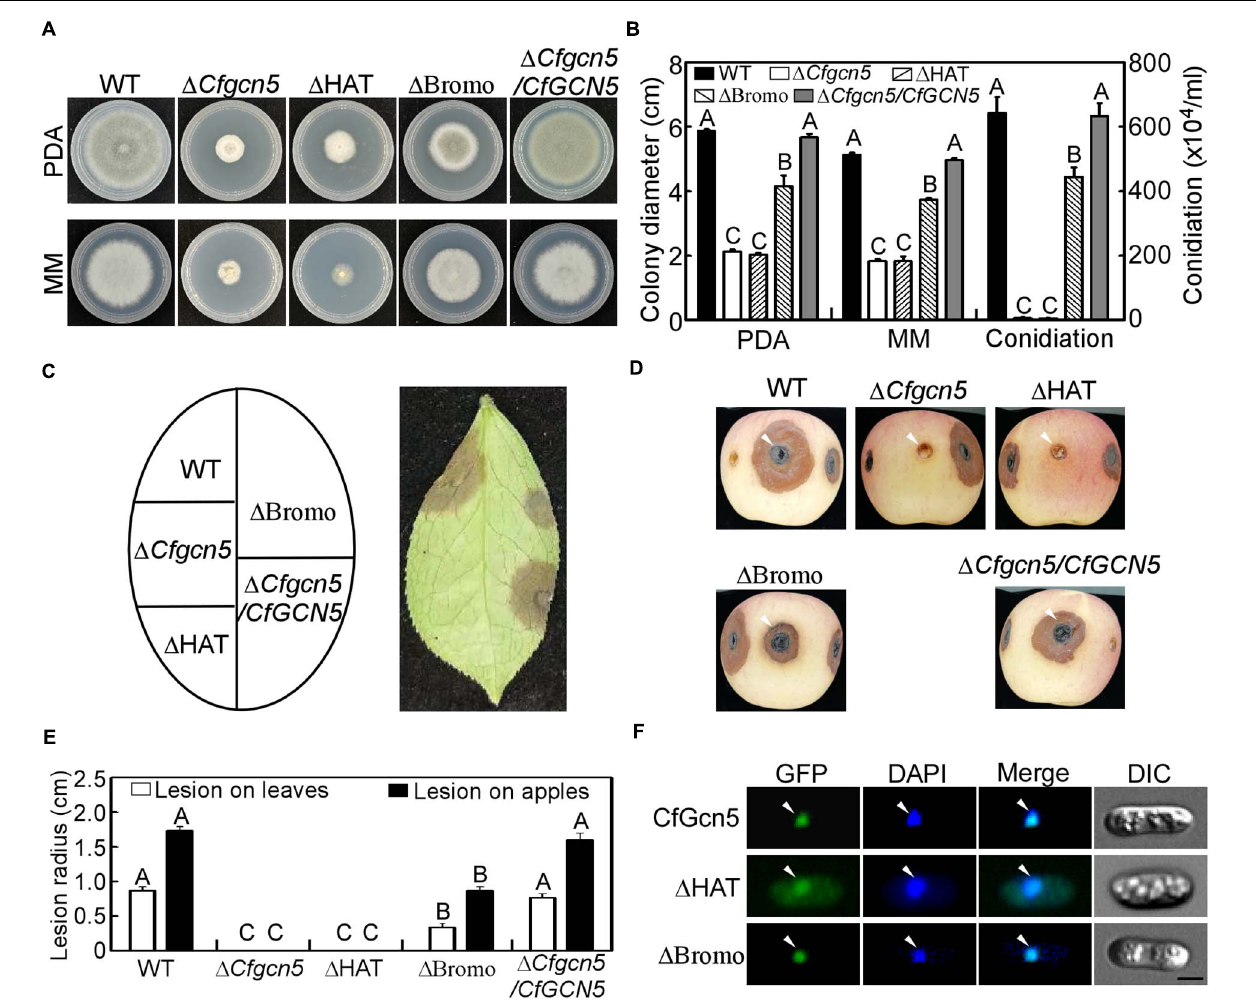
FIGURE 11 | Functional and localized analysis of HAT and Bromo domains. (A) Growth of WT, (cid:49) Cfgcn5 , (cid:49) HAT, (cid:49) Bromo, and (cid:49) Cfgcn5 / CfGCN5 on PDA and MM plates for 4 days. (B) Colony diameters and conidiation were measured and statistically analyzed by Duncan analysis for different strains. Different letters indicate significant difference ( P < 0.01). (C) Diseased symptoms of wounded tea-oil tree leaves inoculated with related mycelial plugs at 4 dpi. (D) Diseased symptoms of wounded apples inoculated with related mycelial plugs at 5 dpi. Arrows indicate the infection area. (E) Statistical analysis of lesion radius on tea-oil tree leaves and apples. Error bars represent SD of three replicates and different letters indicate significant difference ( P < 0.01). (F) The localization of deleted HAT domain ( (cid:49) HAT) and Bromo domain ( (cid:49) Bromo). Arrows show the representative co-localized areas. Bar = 5 µ